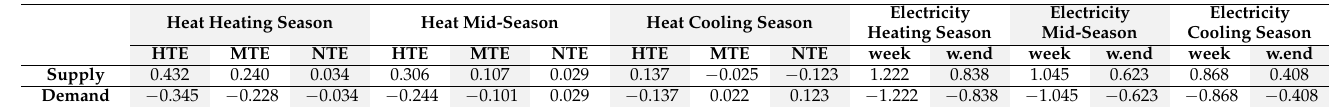
Table 5. Rewarding scheme adopted for the NEST units issued from [35], weighting factors for energy flows.